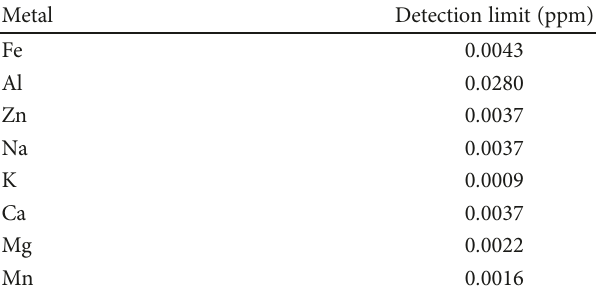
Table 2: Atomic absorption by fl ame.